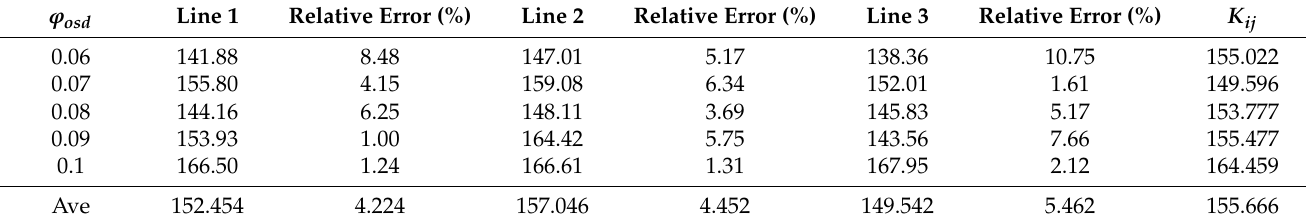
Table 5. Three lines set in the breathing zone and the average MAA on each line when changing ϕ osd .